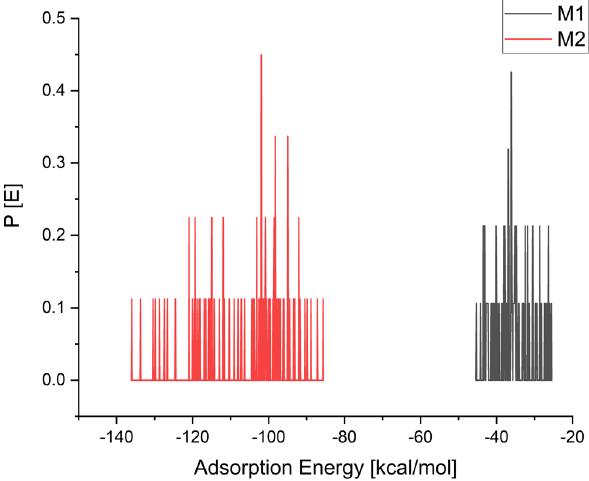
Figure 7: RDF of O and N atoms of M1 and M2 inhibitor molecules on the Cu ( 111 )